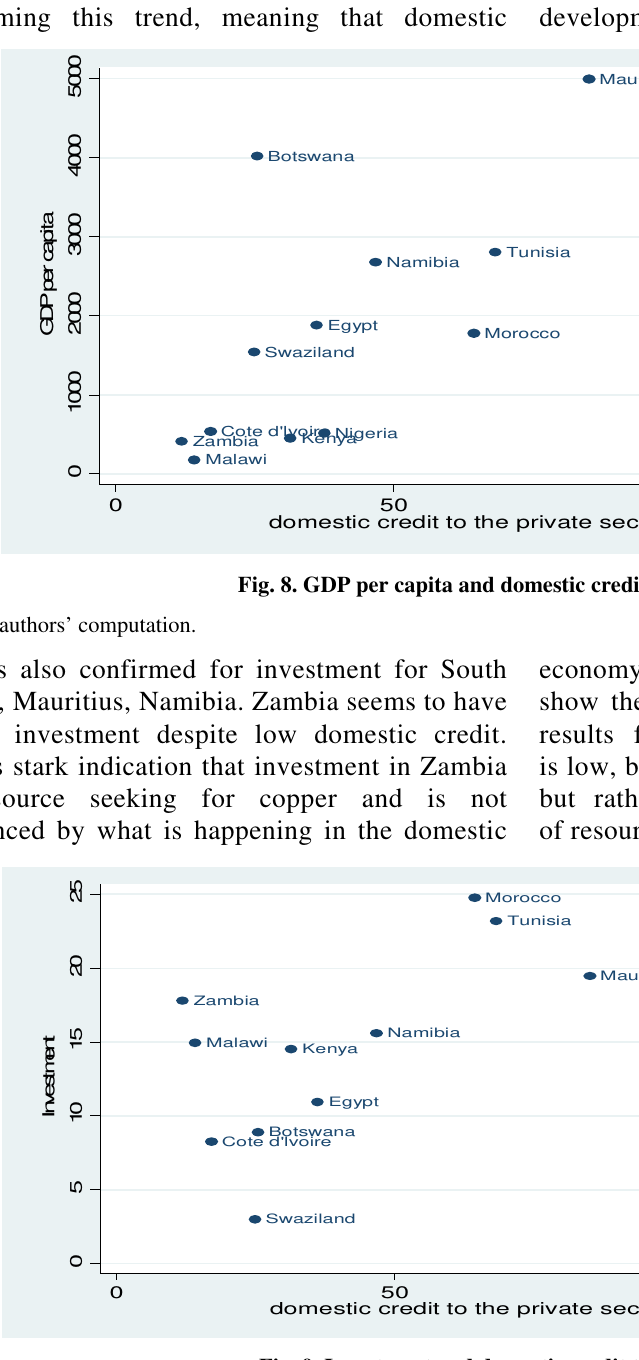
Fig. 9. Investment and domestic credit to private